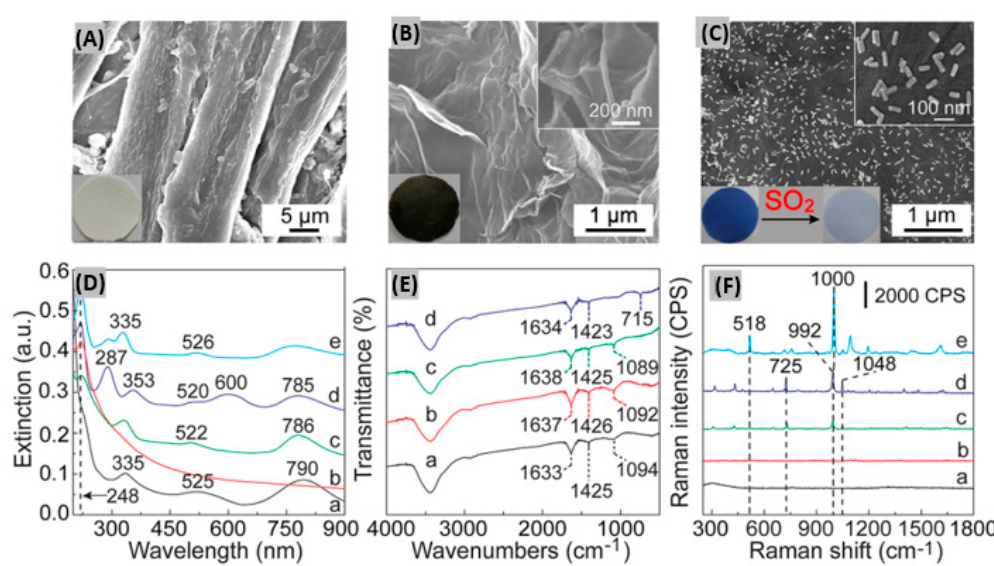
Figure 11. SEM images of ( A ) pure cellulose paper, ( B ) after assembling with rGO and ( C ) rGO/MPy-